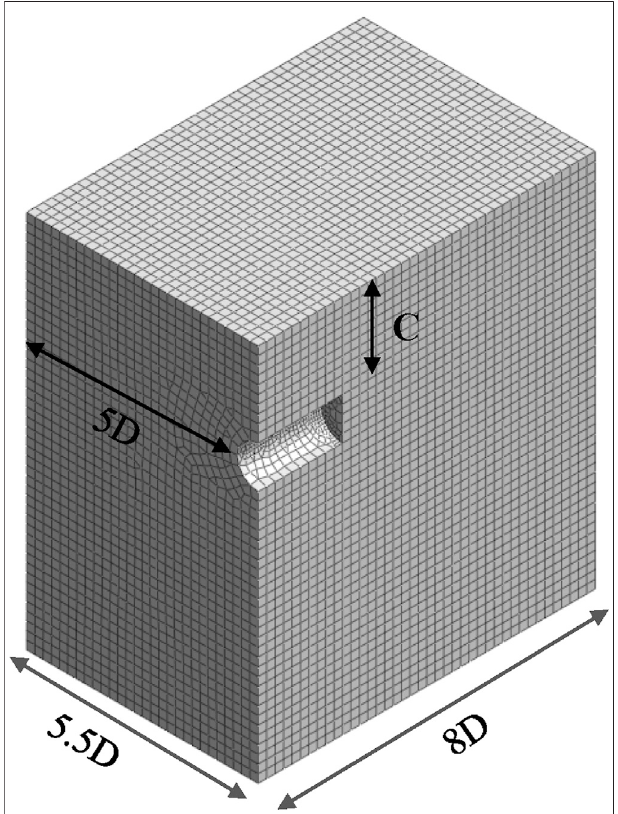
FIGURE 9 | Numerical analysis